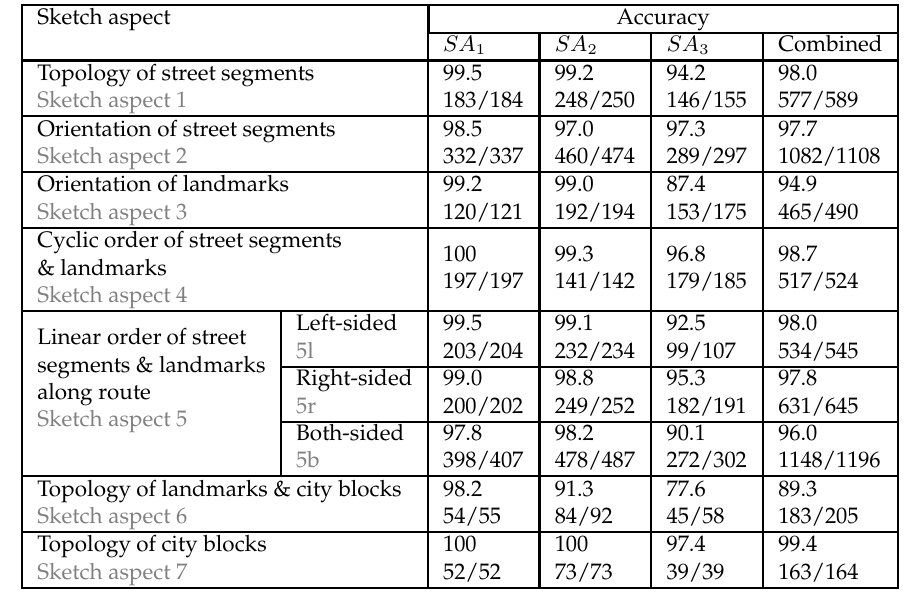
Table 6: Accuracy of proposed sketch aspects ( % and absolute number of correct relations out of all